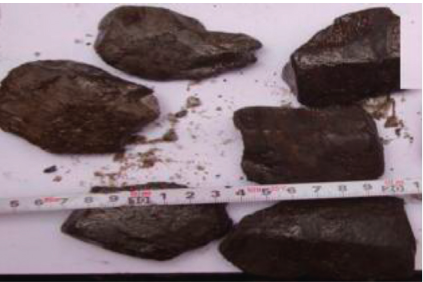
Figure 1: The debris back from the wellhead of W-H1 well (LMX formation)